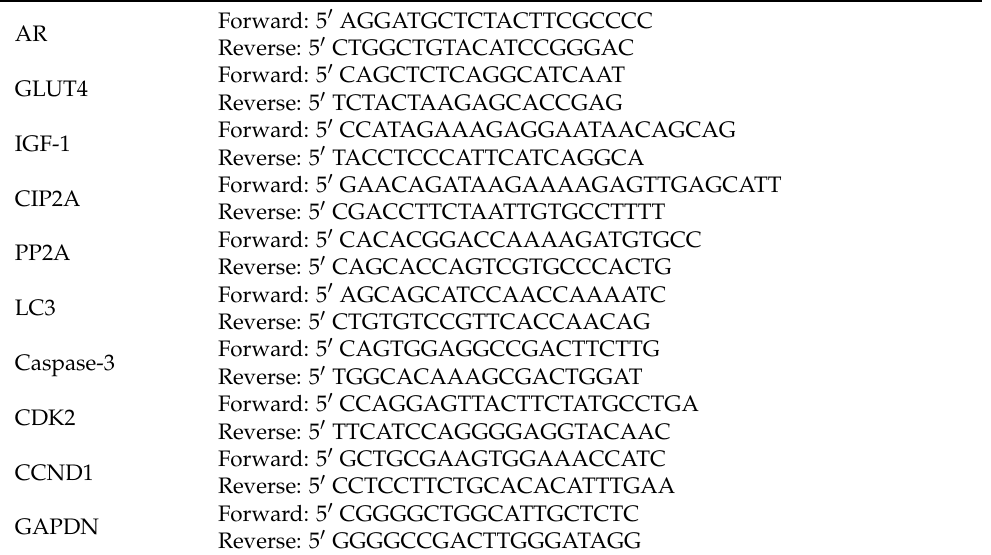
Table 1. Primers used in the